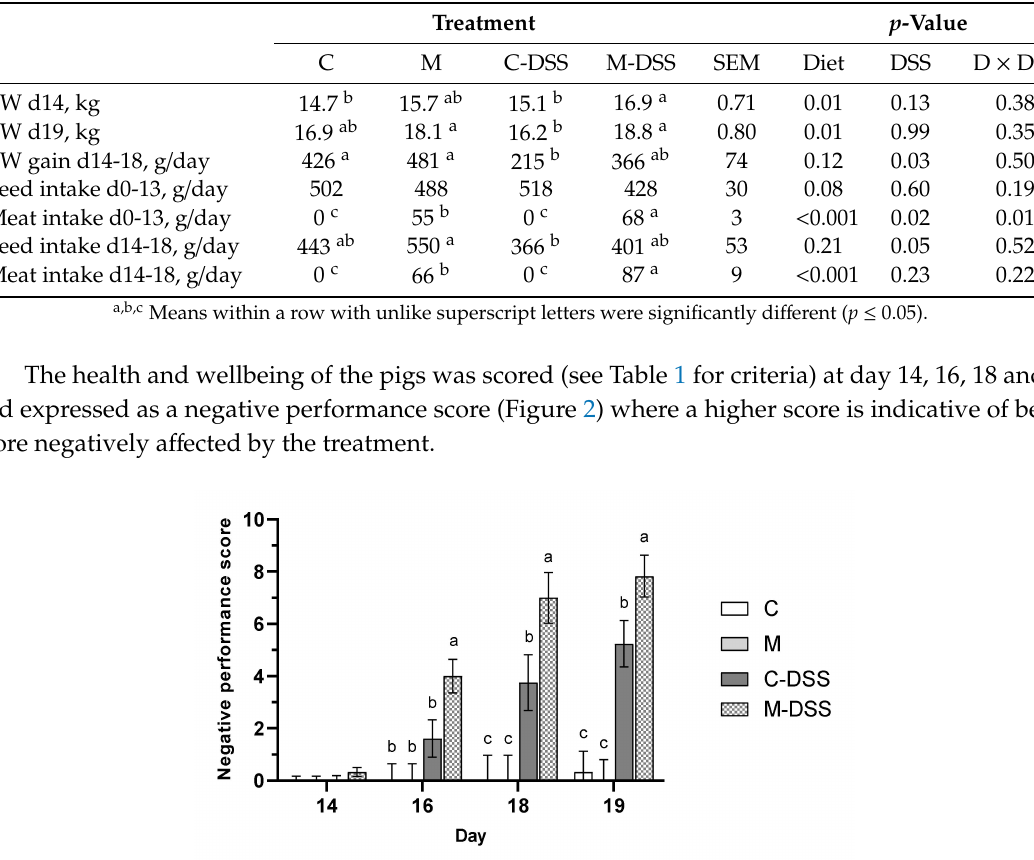
Table 2. Growth performance and feed / meat intake for pigs receiving the four di ff erent treatments. Least square mean values with their standard errors, n = 6 / group except C-DSS n = 5.